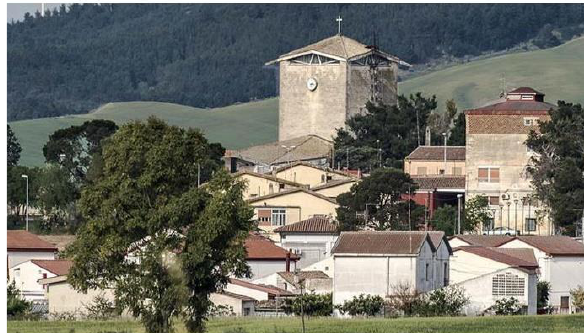
Figure 4. Recent photograph of the current state of conservation of the rural village La Martella in Matera. (© MiBaC Image Copyright